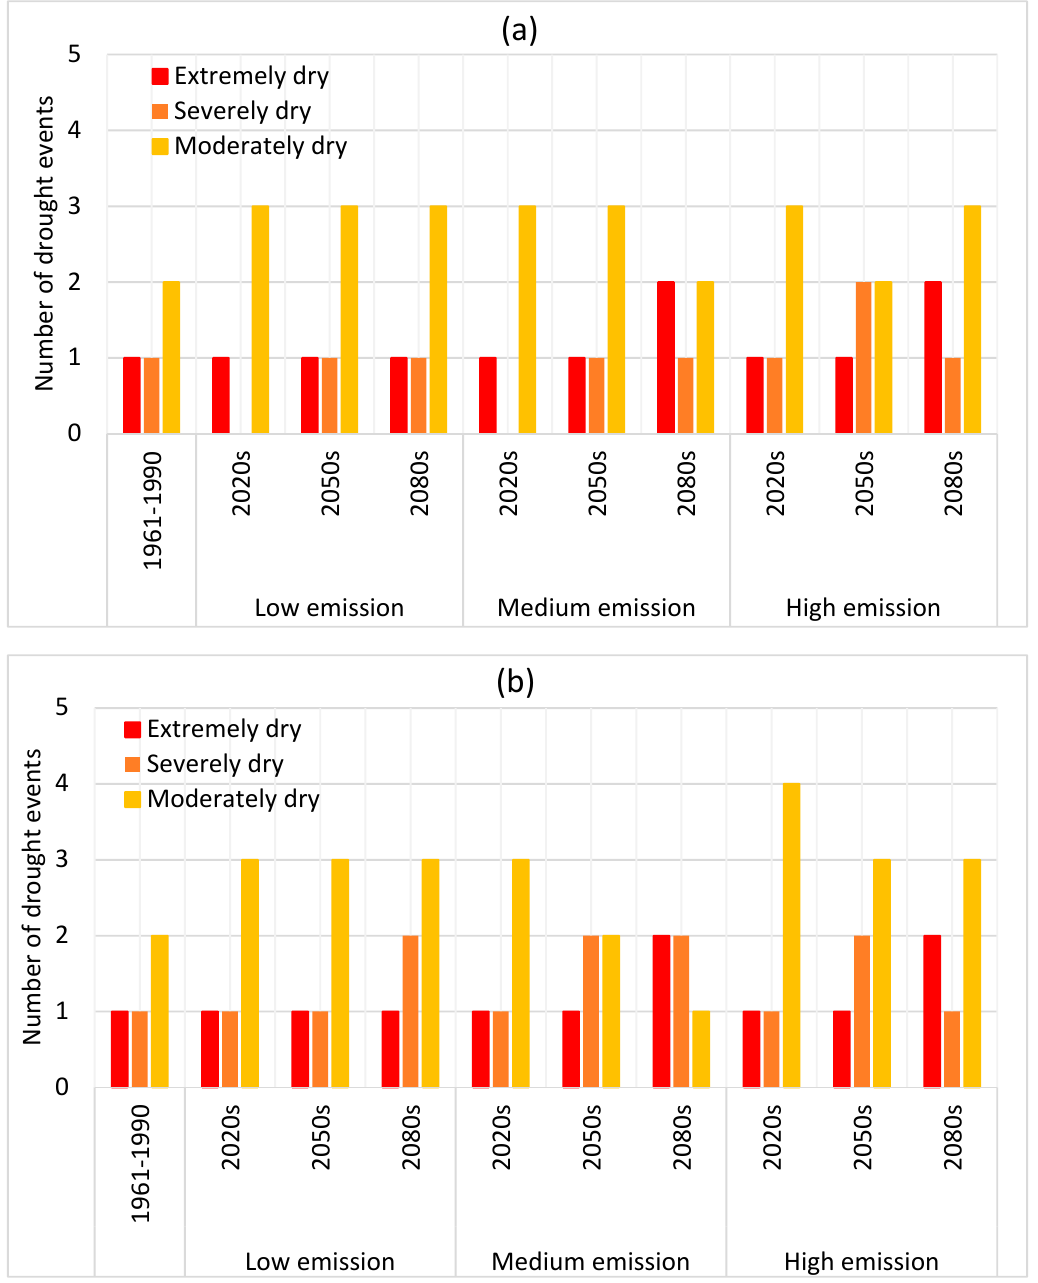
Figure 14. Drought event severity observed in the Frome catchment under low, medium and high emission scenarios for the 2020s, 2050s and 2080s, Figure ( a ) shows the drought severity using joint probability data and ( b ) when using the weather generator data.